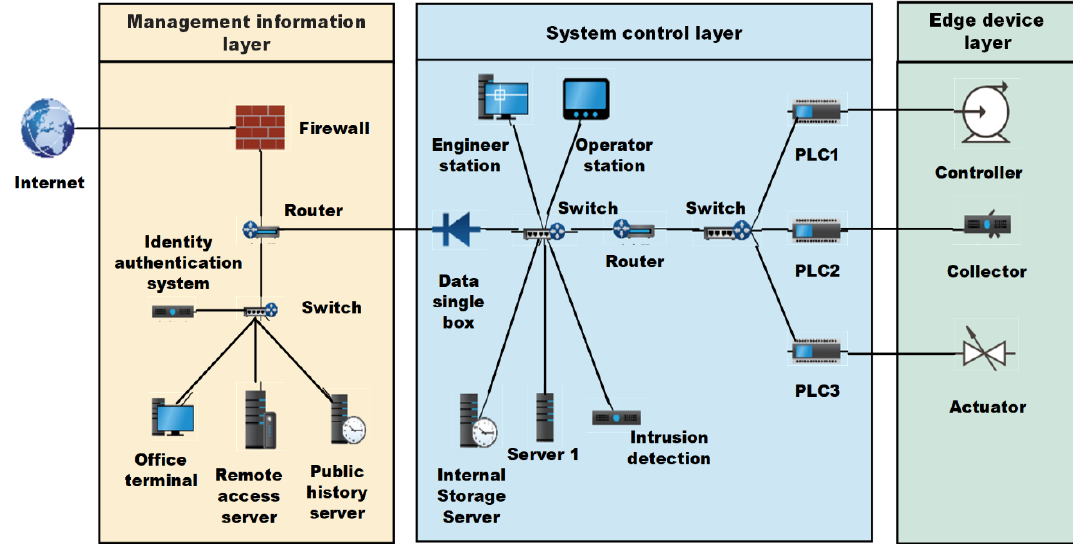
Figure 1. Typical architecture of layered industrial internet system.